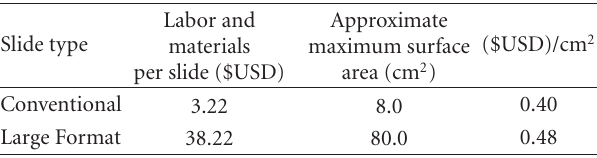
Table 8: Direct labor and material expense per finished slide ex- cluding amortization, year 2005. Comparison of conventional and large-format slides. $USD. N = 50 cases.